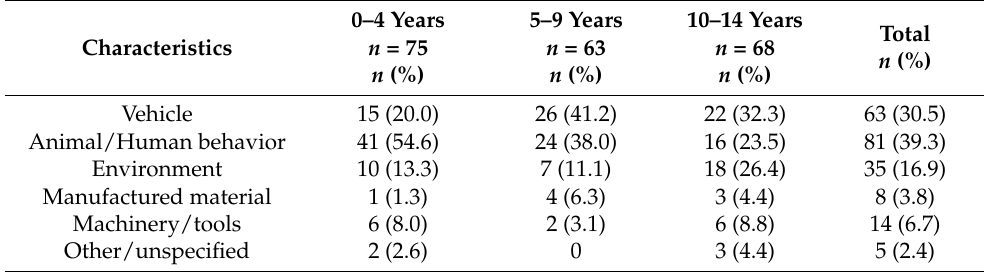
Table 4. Agency triggering the work-related incident (breakdown agent), among children (0–14 years), New Zealand,